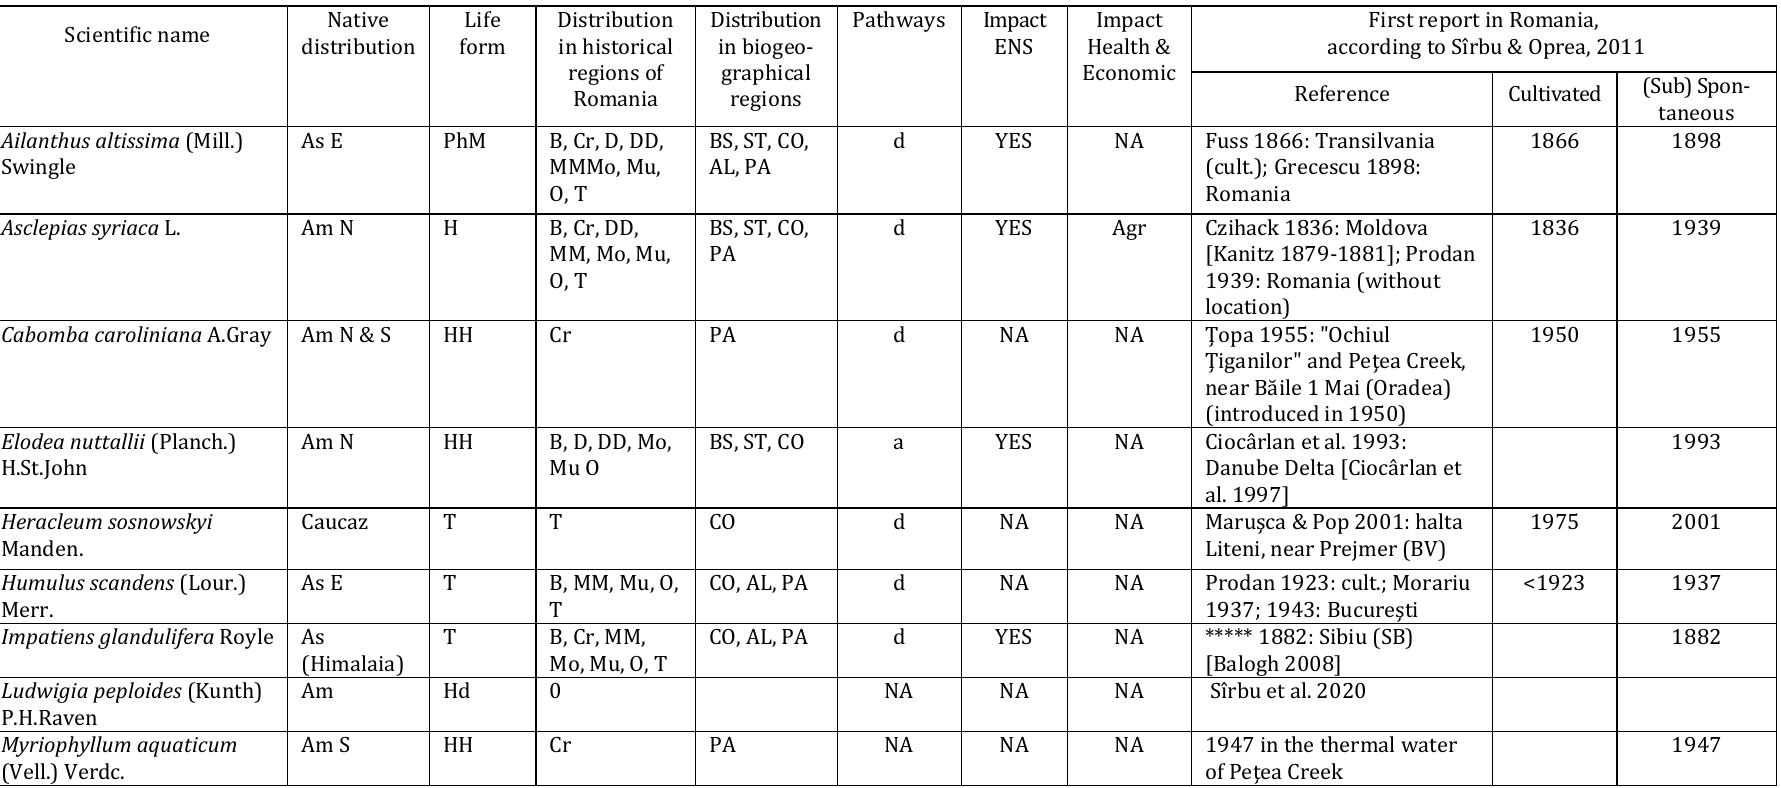
Table 1. Alien plant species occurring in Romania of European Union concern, according to Regulation